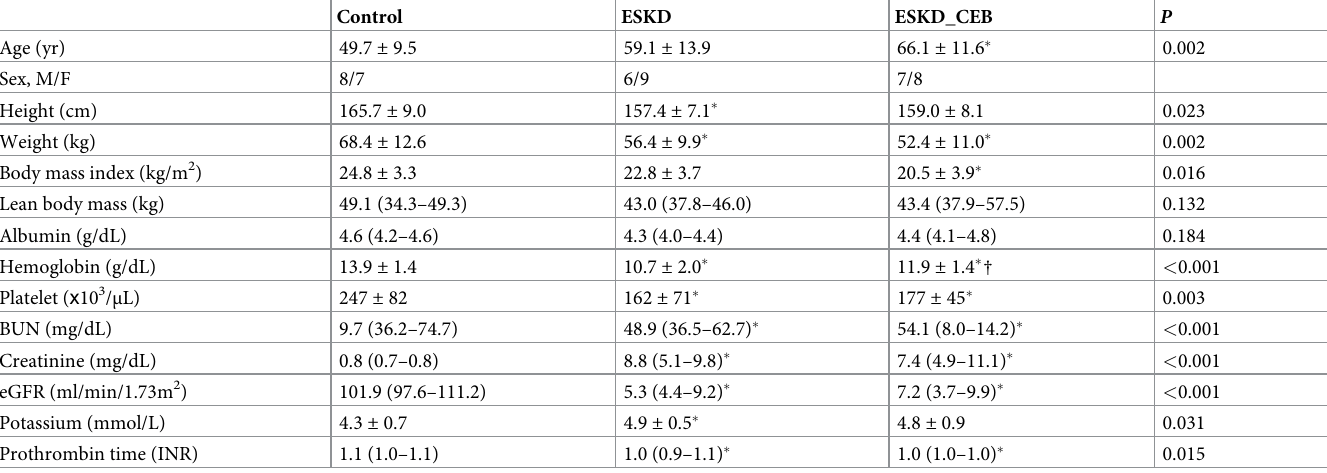
Table 1. Patient characteristics and preoperative laboratory values.